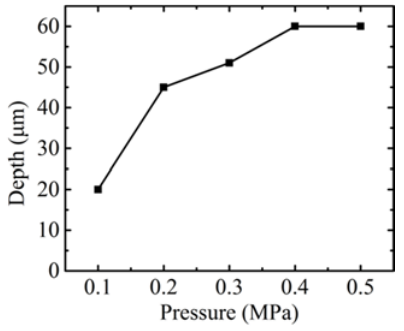
Figure 6. The influence of pressure on depth.